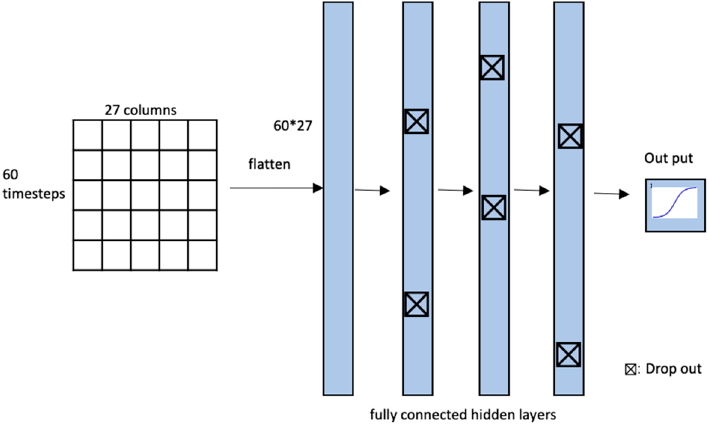
Figure 5. DNN architecture and vital record processing for DNN.